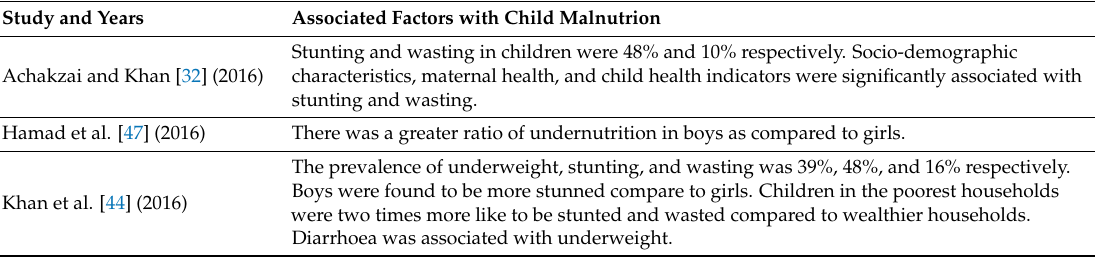
Table 2. Major findings of studies included in the